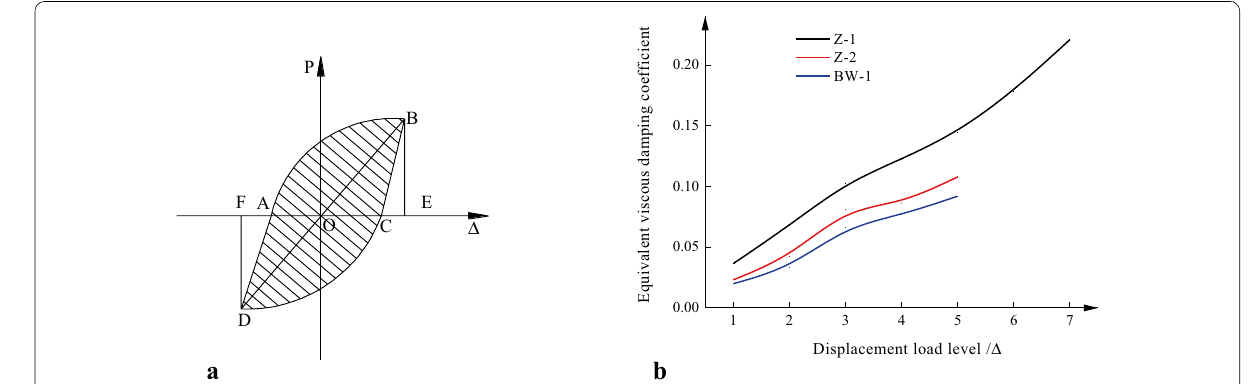
Fig. 8 a Energy dissipation profile and b equivalent viscous damping coefficient